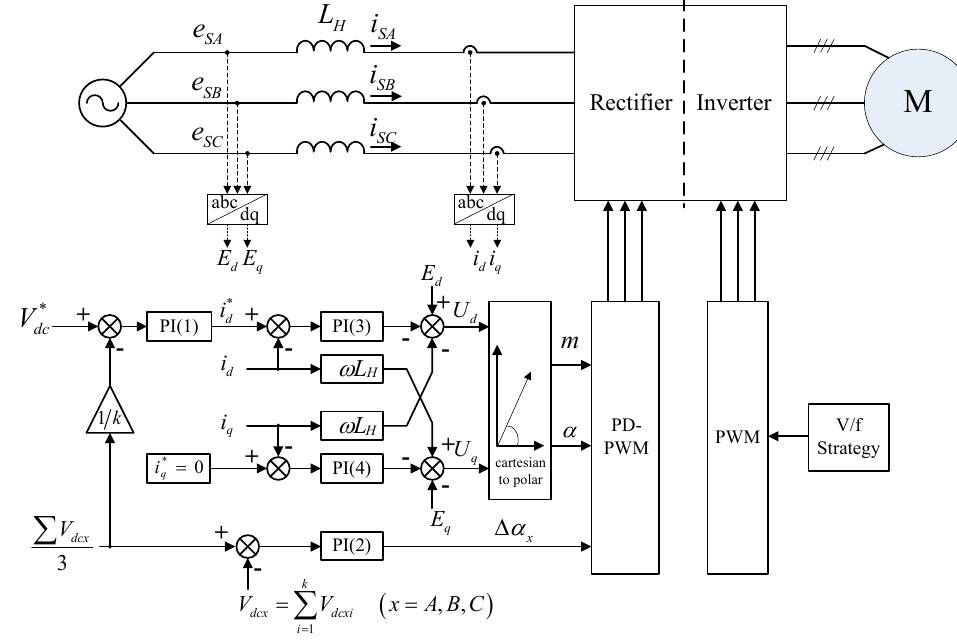
Figure 2. Control block diagram of the proposed multiphase motor drive system.